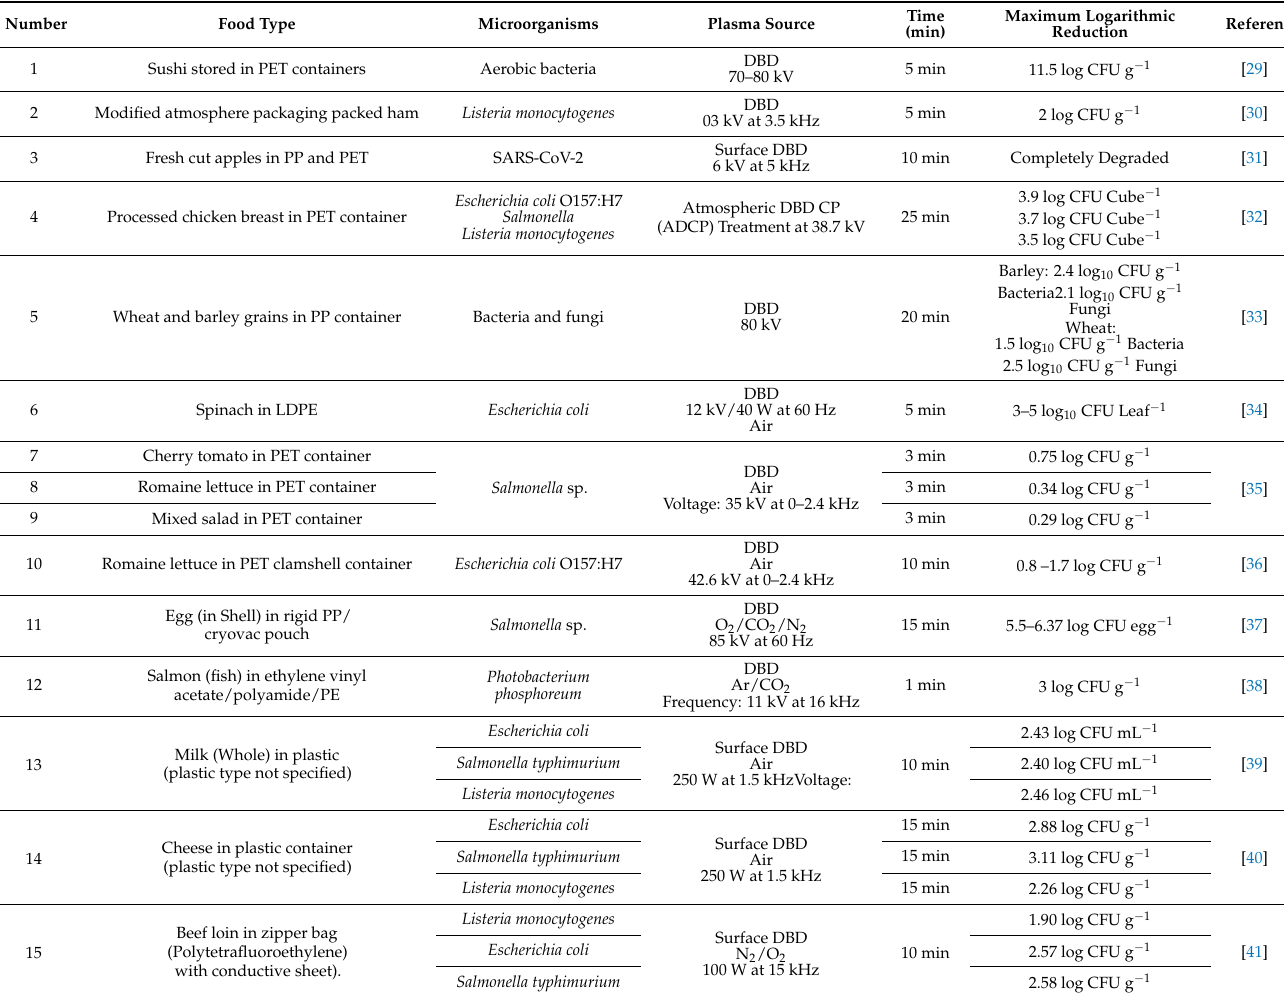
Table 1. CP inactivation of microorganisms on food packaging